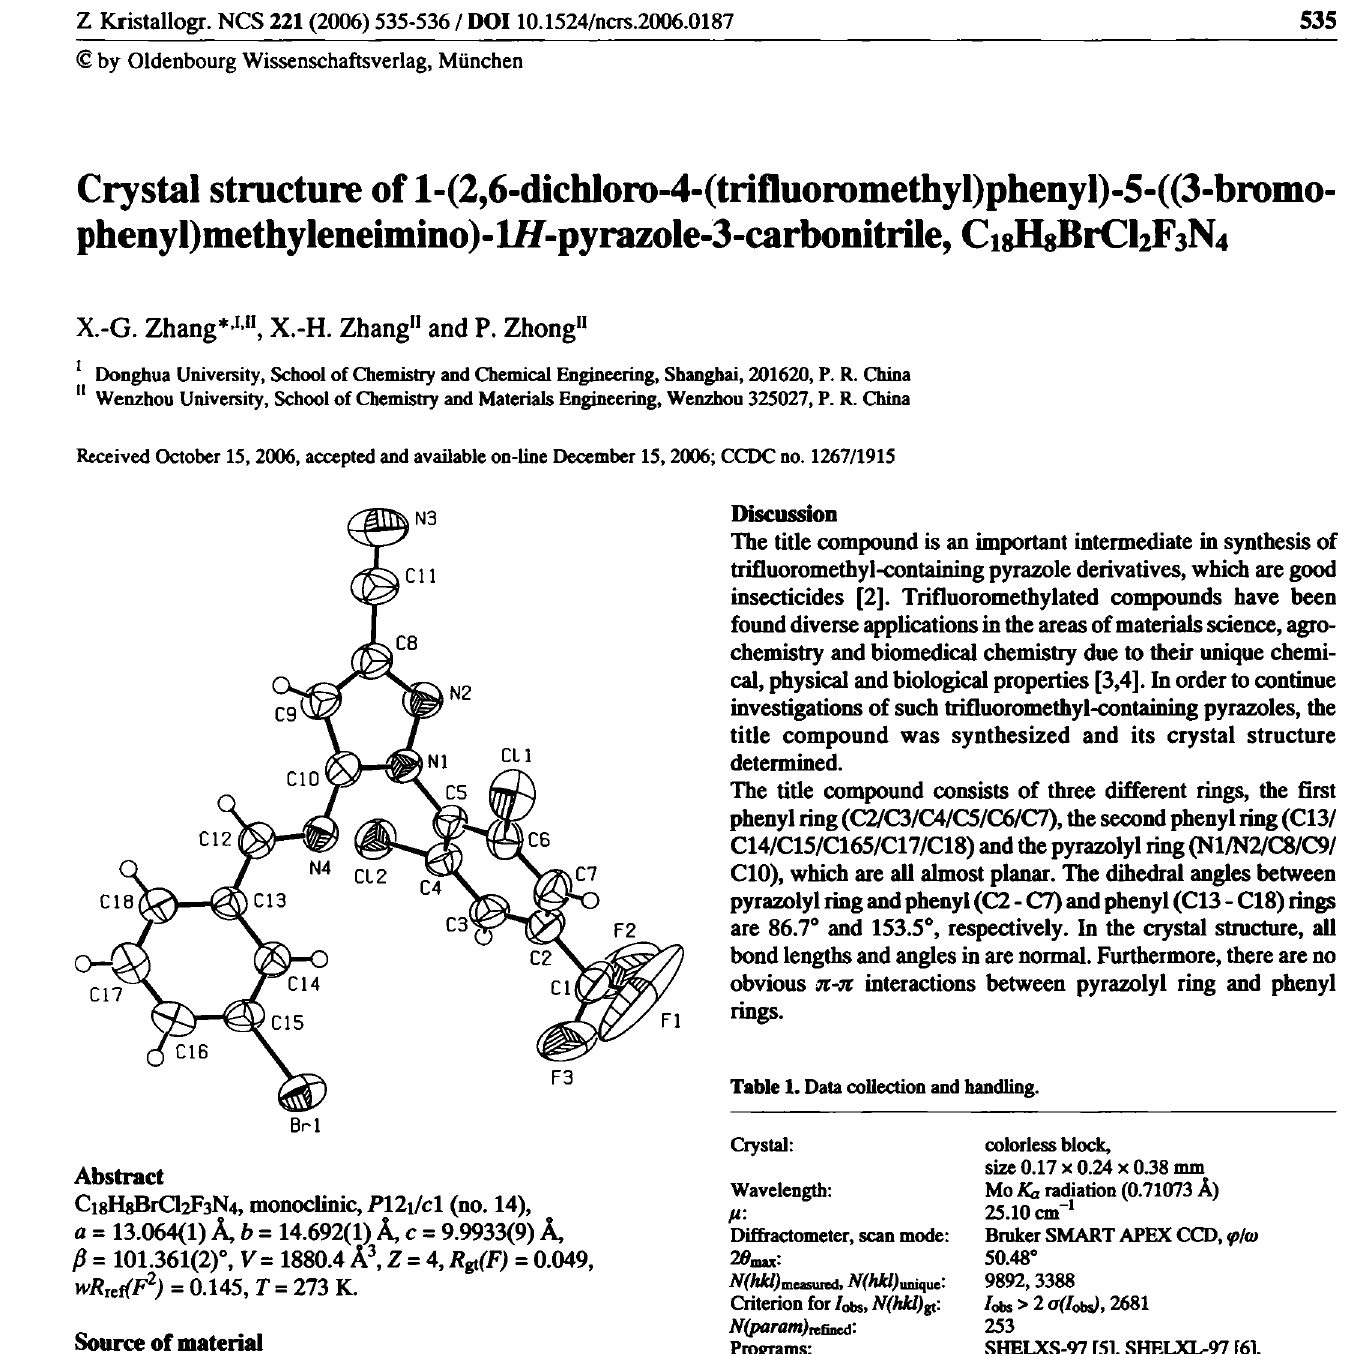
Table 2. Atomic coordinates and displacement parameters (in Ä 2